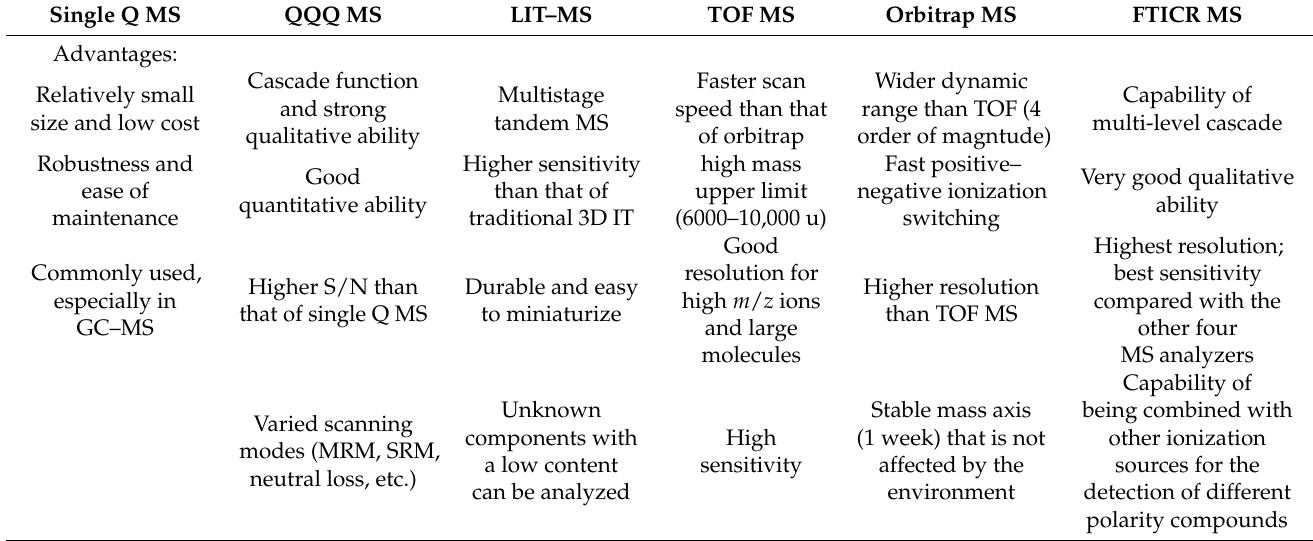
Table 3. Comparison of different MS analyzers for PQ and